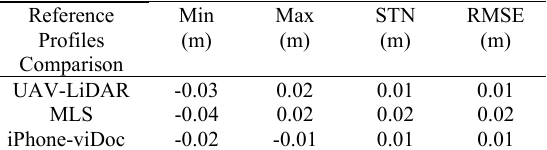
Table 2. Error statistics values of longitudinal profile differences